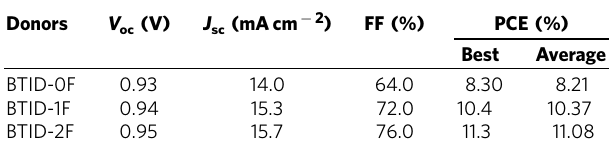
Table 1 | Optimized photovoltaic performance of inverted device based on the three molecules (device structure: ITO/ ZnO/active layer/MoO x